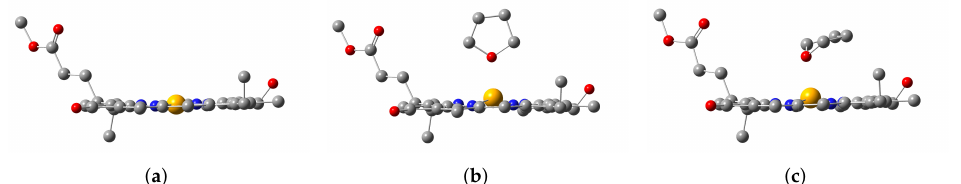
Figure 3. Configurations of ( a ) Znchl monomer (model 1), ( b ) THF-Znchl without dispersion correc- tion (model 2), and ( c ) THF-Znchl with dispersion correction (model